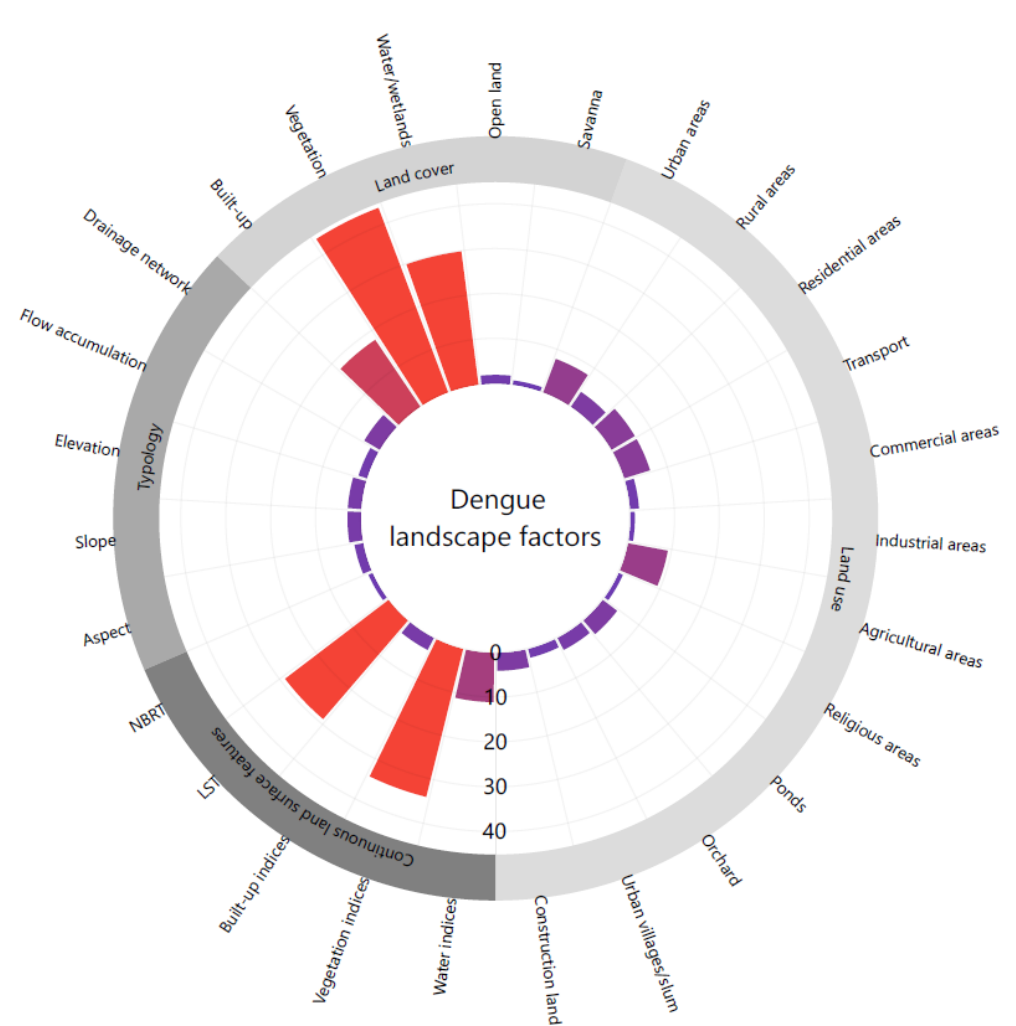
Figure 3. Overview of essential dengue landscape factors derived from the selected articles.